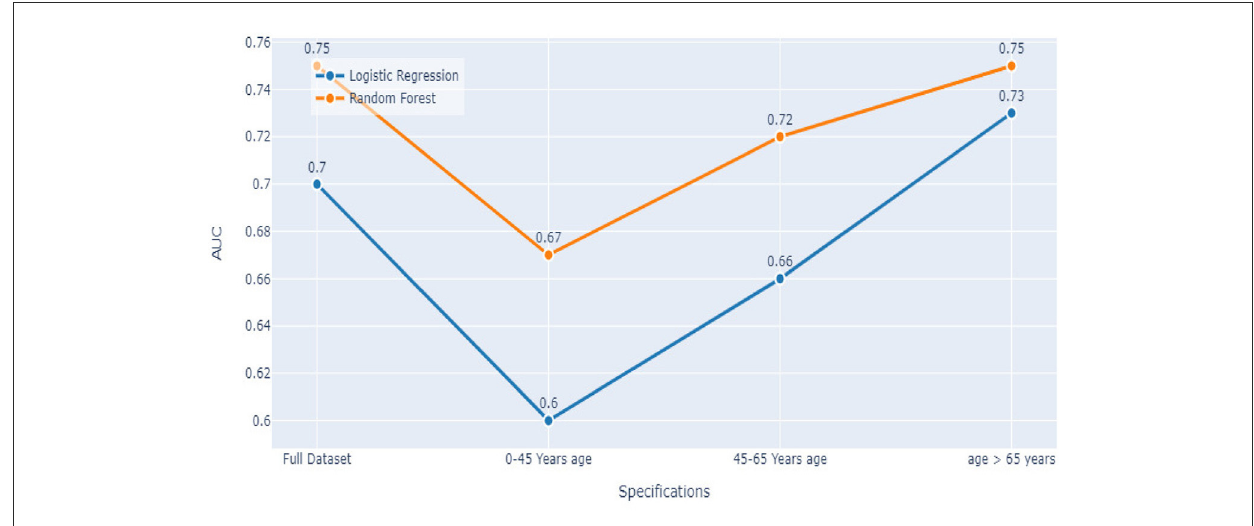
FIGURE8 Models AUC score